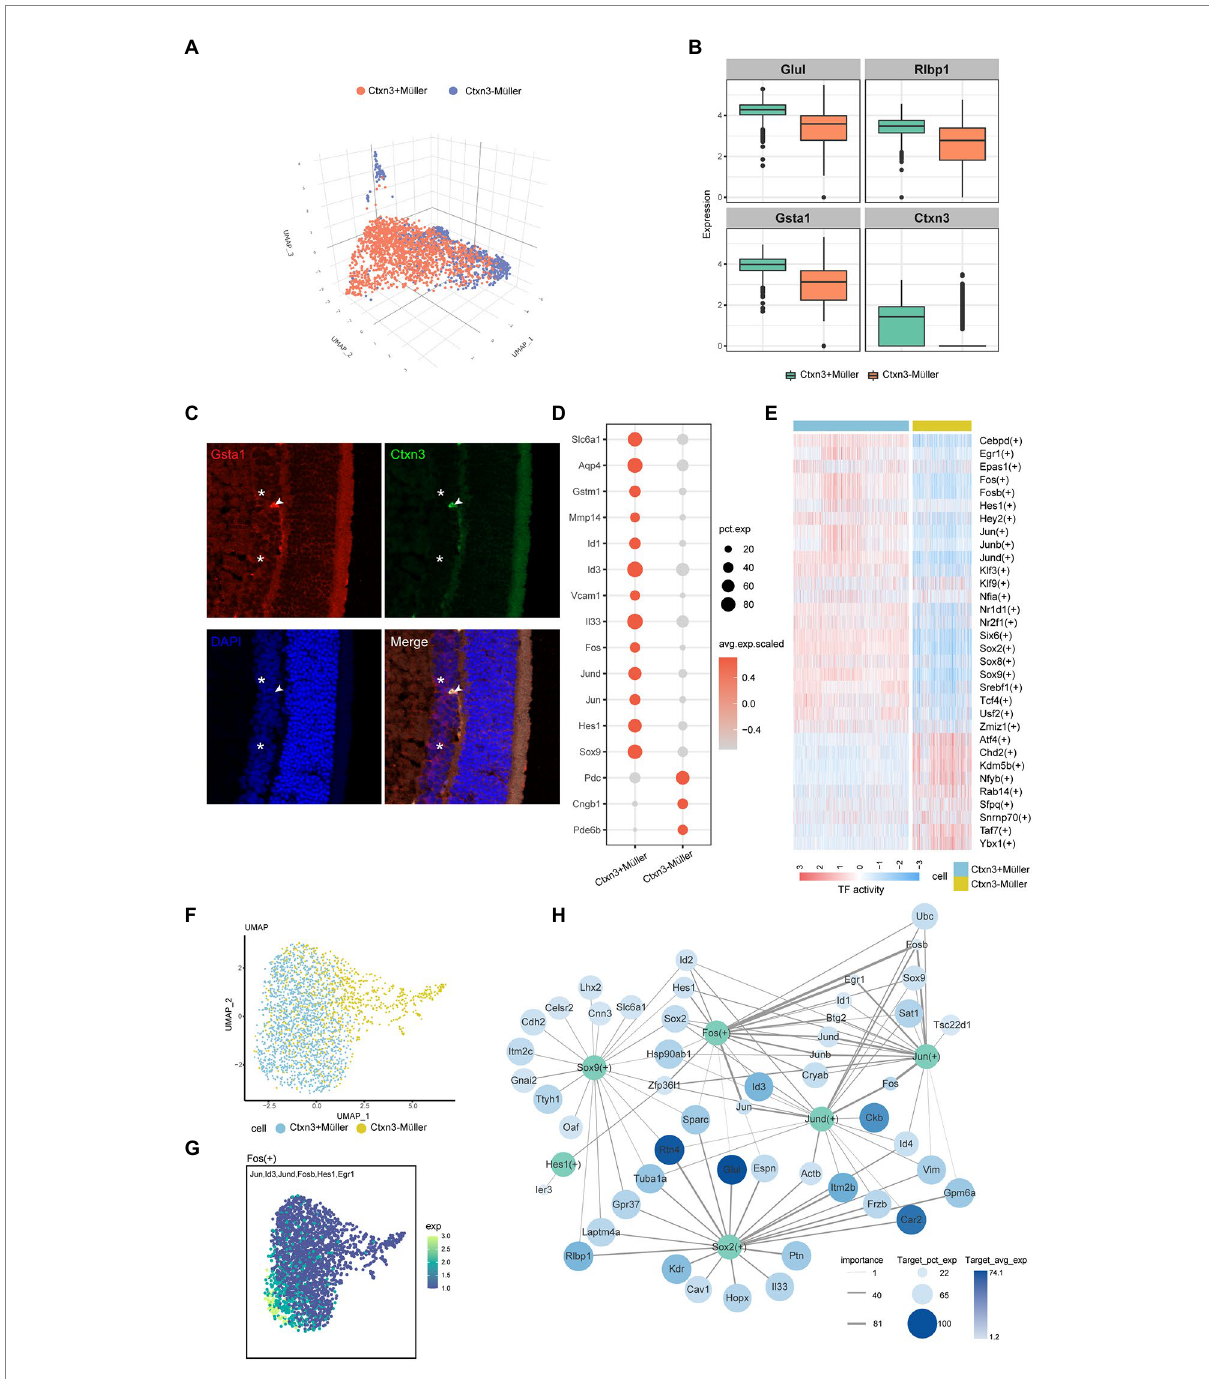
FIGURE 2 The characteristics of the two subtypes of Müller cells. (A) Three-dimensional UMAP plot of Ctxn3 + Müller and Ctxn3 − Müller cells. The different colors correspond to different cell types. (B) Box diagram showing the expression of the marker genes, which distinguishes the two groups of Müller cells. (C) Immunofluorescence labeling for Gsta1 (red) and Ctxn3 (green) and DAPI nuclear staining (blue) in the rat retina. Ctxn3 + Müller are indicated by arrowheads, and Ctxn3 − Müller are indicated by asterisk (40×, scale bar 20 μ m). (D) The bubble plot shows the expression of important cytokines in Ctxn3 + Müller and Ctxn3 − Müller cells. The bubble size represents pct.exp., and the color represents avg.exp.scaled. (E) Heatmap showing the activity of important TFs in Ctxn3 + Müller and Ctxn3 − Müller cells according to AUCell. (F) UMAP plot showing two subclusters of Müller cells. (G) UMAP showing the expression of target genes of Fos. The color from dark to light represents increased expression. (H) The network diagram shows the important TFs in Ctxn3 + Müller cells and their downstream target gene associations. TFs are shown in green, and the color of the target gene represents Target_avg_exp; the size of the circle represents Target_pct_exp, and the line thickness represents importance. TF with avg. exp. > 6 among the top 10 avg. exp. * pct.exp. values was selected as the research object. We selected the top 20 genes by the Target_ avg_exp*importance value among the target genes with importance >5 for each